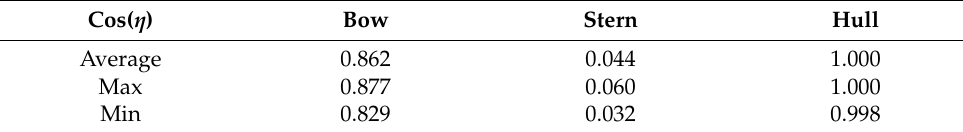
Table 4. Normal vector comparison of bow, stern, and hull with ship’s